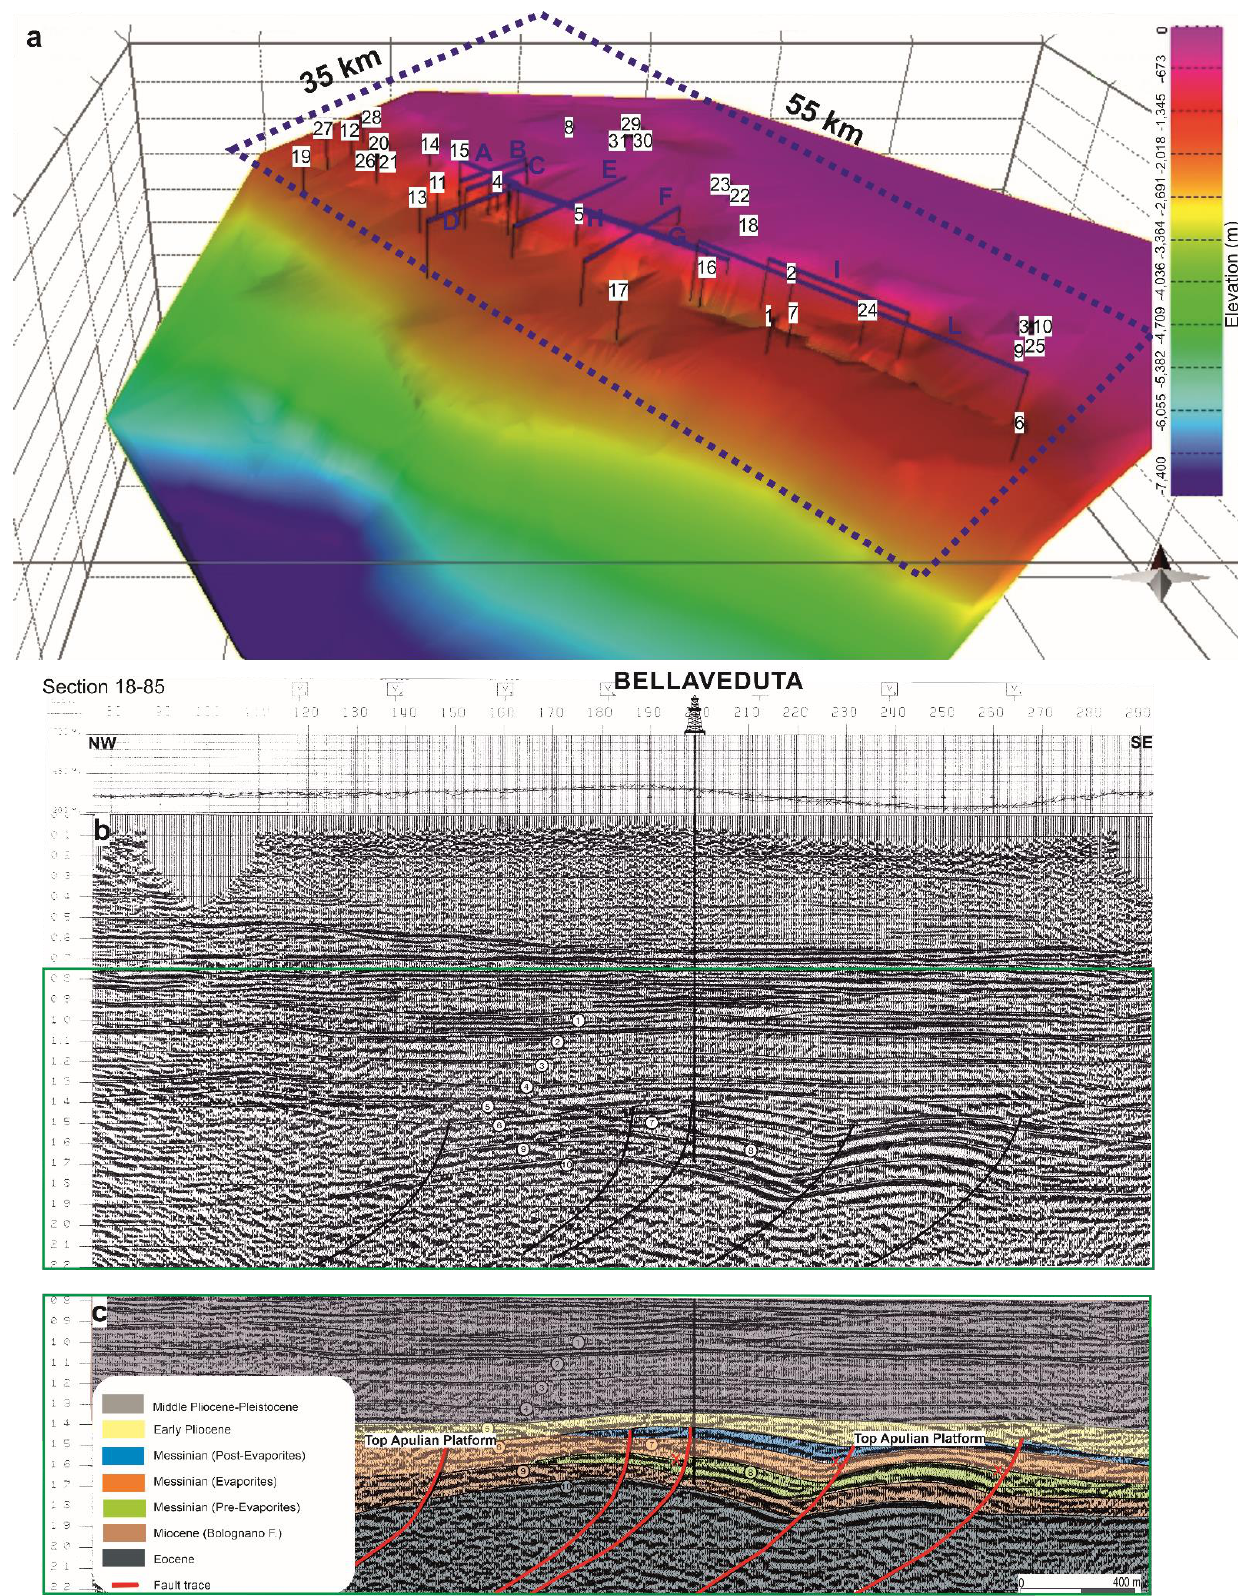
Figure 3. ( a ) Isobath map of top Apula surface (Upper Cretaceous to Messinian age) obtained after 2D seismic reflection and well log data interpretation, and by taking into account the isobath map by Nicolai and Gambini [77]. The color bar on the right shows the surface elevation in meters